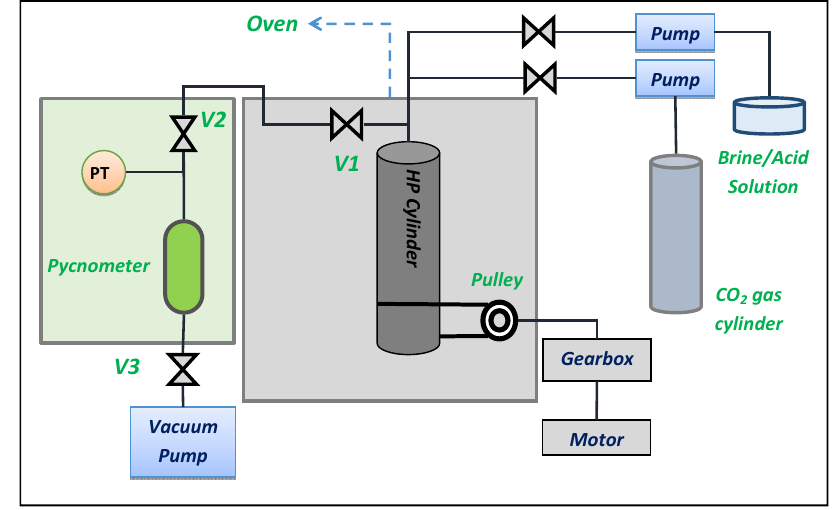
Figure 1. Schematic of the set-up used for the experiments. PT: Pressure Transducer; HP: High Pressure.